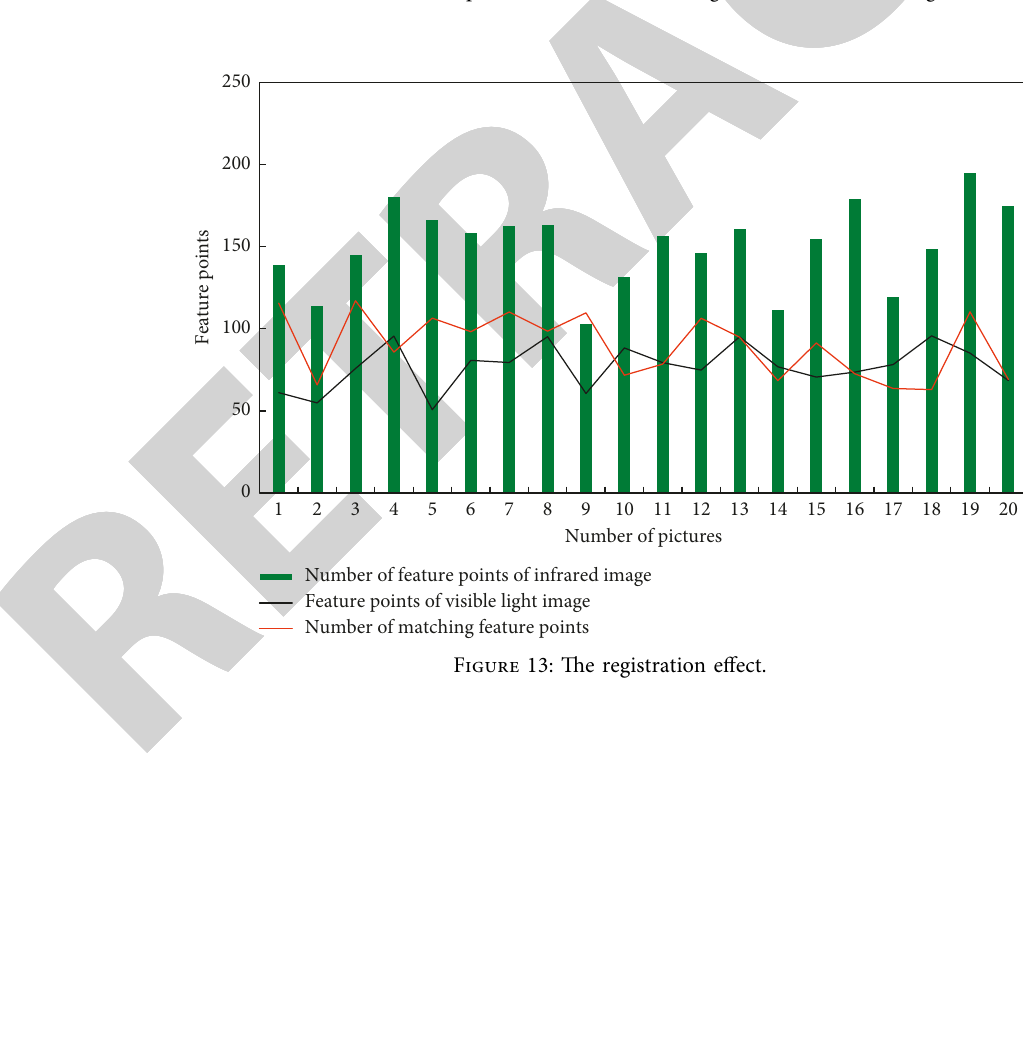
Figure 12: Some data comparison between the sift algorithm and the surf